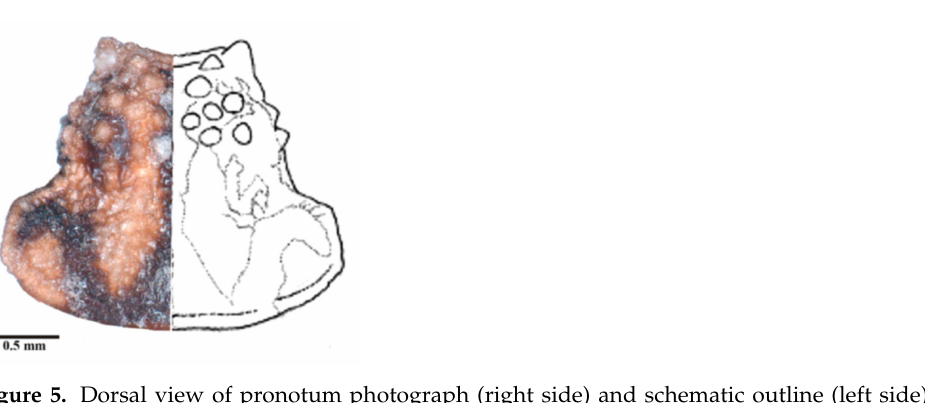
Figure 5. Dorsal view of pronotum photograph (right side) and schematic outline (left side) of Belminus santosmalletae sp. n., showing the anterior lobe with 7 + 7 discal tubercles and 2 + 2 lateral tubercles.